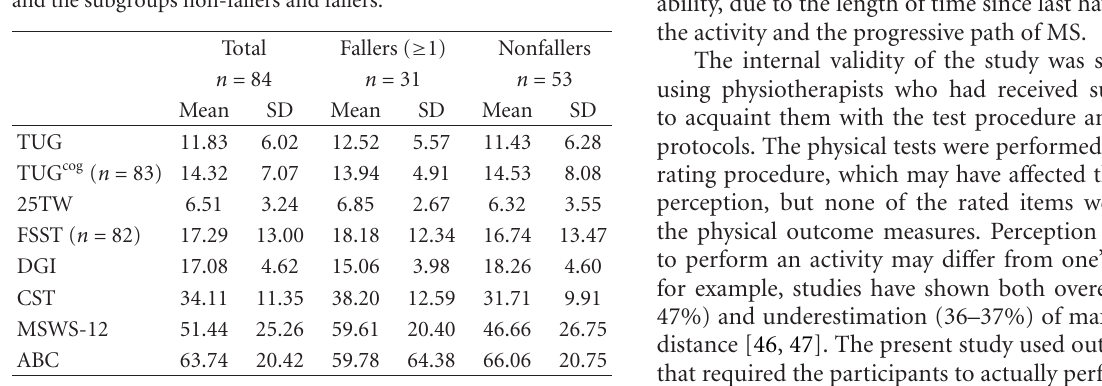
Table 3: Mean and SD of the outcome measures for the total sample and the subgroups non-fallers and fallers.